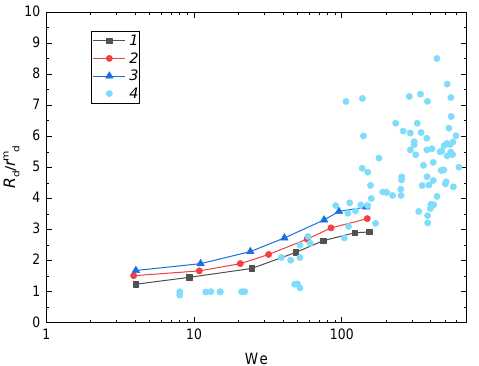
Figure 11. Ratio between the initial drop radius and maximum radius of secondary droplets vs. We: 1 — [8]; 2 — [9]; 3 — [10]; 4 — experimental data for water.